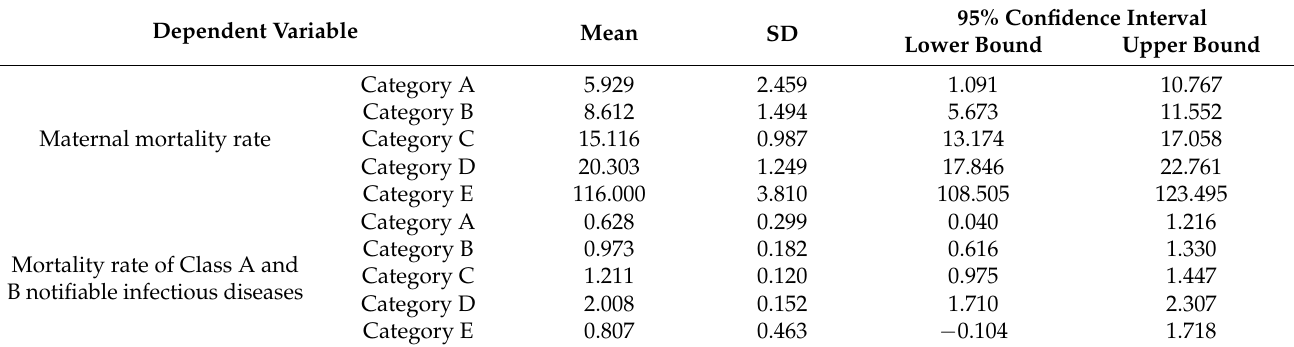
Table 4. Descriptive statistics of two diseases.